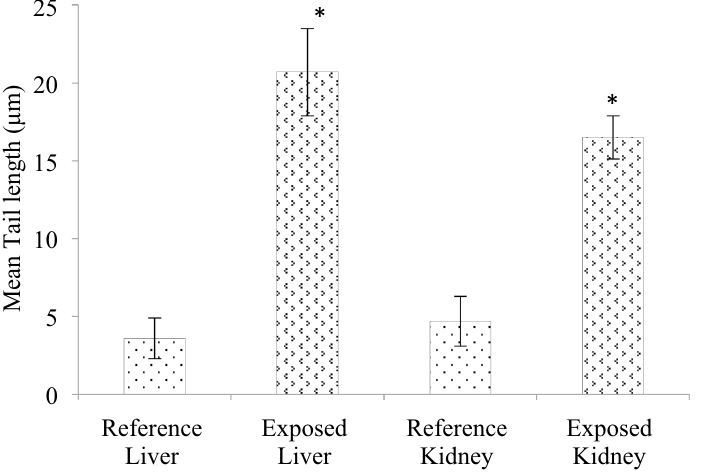
Figure 3. The effects of heavy metals on DNA damage in reference and exposed O. niloticus liver and kidney tissues. Data represented mean ± SEM, (n = 6); t-test was used for statistical analysis and level of significance established at p < 0.05.